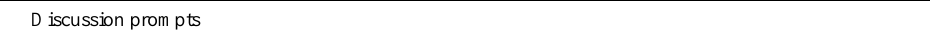
Table 2. Focus group and interview discussion prompts.